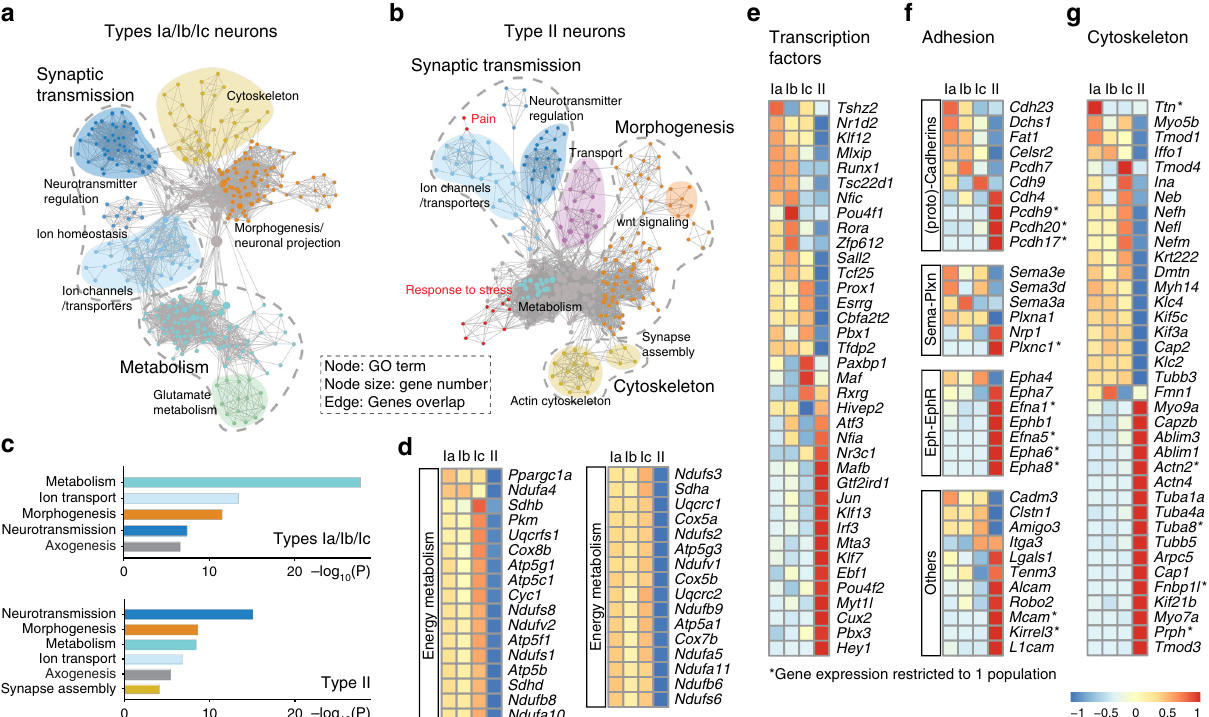
Fig. 2 Comparative analysis of SG neurons transcriptomes. a , b Gene set enrichment analysis of types I ( a ) and type II neurons ( b ) visualized by network. Each node represents a GO term, edges are drawn when there are shared genes between two GO terms. c Gene ontology analysis of the type I and type II group. The graph shows most signi fi cant terms re fl ecting neuronal features. d Heatmaps showing expression of genes associated with energy metabolism in each subclass of SG neurons. e – g Differential expression of transcription factors ( e ), cell-adhesion molecules including Cadherin, Semaphorin, and Ephrin family ( f ) and of cytoskeleton-related genes among the four subclasses of SG neurons ( g ) (see also Supplementary Fig.